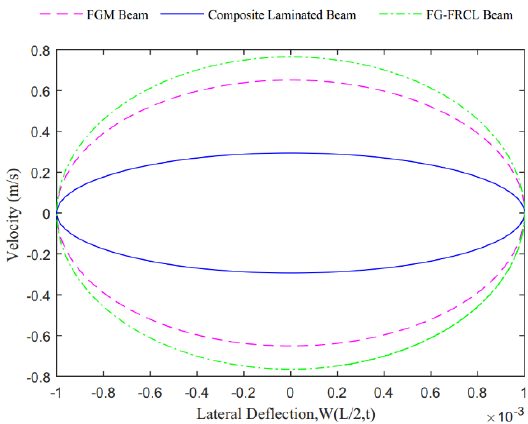
Figure 7. Phase trajectory of three different type of beams.